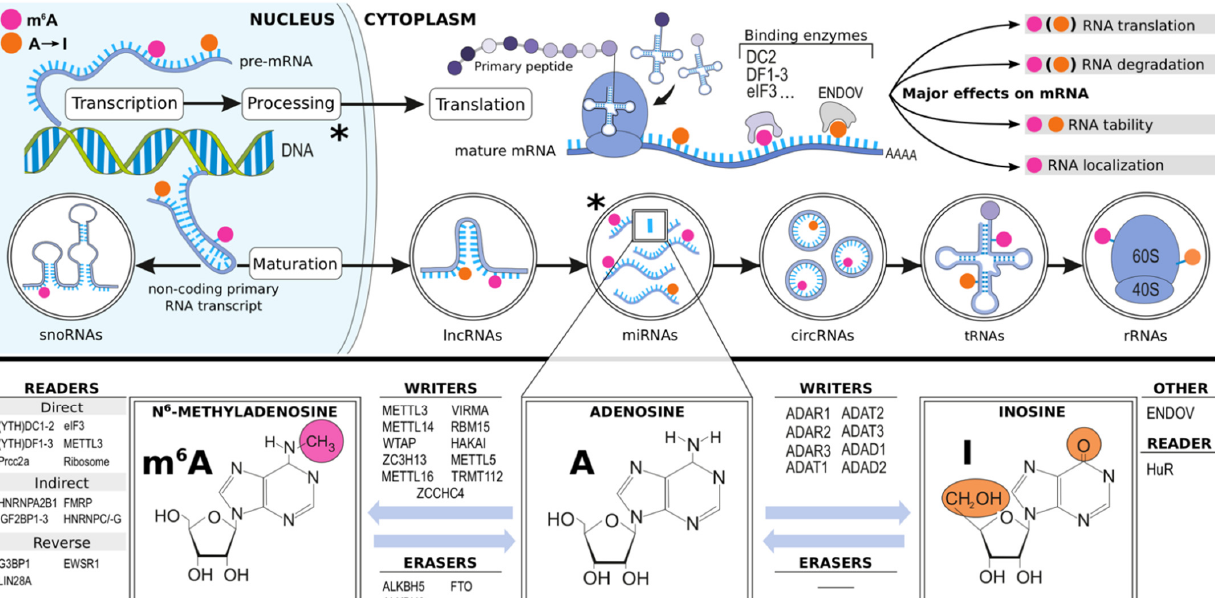
Figure 1 . Overview of the RNA m 6 A modification and A-to-I RNA editing and their known writers, readers, and erasers. m 6 A modification and A-to-I editing occur in most RNA species. ADAD1-2 , adenosine deaminase domain-containing protein 1-2; ADAR1-3 , double-stranded RNA-specific adenosine deaminase 1-3; ADAT1-3 , adenosine deaminases acting on tRNAs; ALKBH5 , alkB homolog 5 RNA demethylase; A-to-I, adenosine-to-inosine RNA editing; circRNA , circular RNA; ENDOV , human endonuclease V; eIF3 , eukaryotic initiation factor 3; EWSR1 , Ewing sarcoma breakpoint region 1 protein; FMRP , fragile X retardation protein; FTO , fat mass and obesity associated protein; G3BP1 , Ras GTPase-activating protein- binding protein 1; HAKAI , E3 ubiquitin-protein ligase Hakai; HNRNP-A2B1,-C,-G , heterogeneous nuclear ribonucleoprotein A2/B1 and C1/C2 and G; HuR , human antigen R; IGF2BP1-3 ; The insulin-like growth factor-2 mRNA- binding proteins 1, 2, and 3; LIN28A , Lin-28 homolog A; lncRNA , long non-coding RNA; METTL3,-14,-16 , N6- adenosine- methyltransferase catalytic subunit/non-catalytic subunit/METTL16; METTL5 , methyltransferase Like 5; mRNA , messenger RNA; miRNA , microRNA; Prcc2a , proline rich coiled-coil 2 A; RBM15 , RNA binding motif protein 15; rRNA , ribosomal RNA; snoRNA , small nucleolar RNA; TRMT112 , TRNA methyltransferase subunit 11-2; tRNA , transfer RNA; VIRMA , vir like m 6 A methyltransferase associated; WTAP , Wilm's tumor associated protein; (YTH)DC1-2, YTH domain- containing protein 1 ja 2; (YTH)DF1-3 , YTH N6-methyladenosine RNA binding protein 1-3; ZCCHC4 , zinc finger CCHC- type containing 4; ZC3H13 , zinc finger CCCH domain-containing protein 13; *, miRNAs can also derive from pre-mRNA introns.